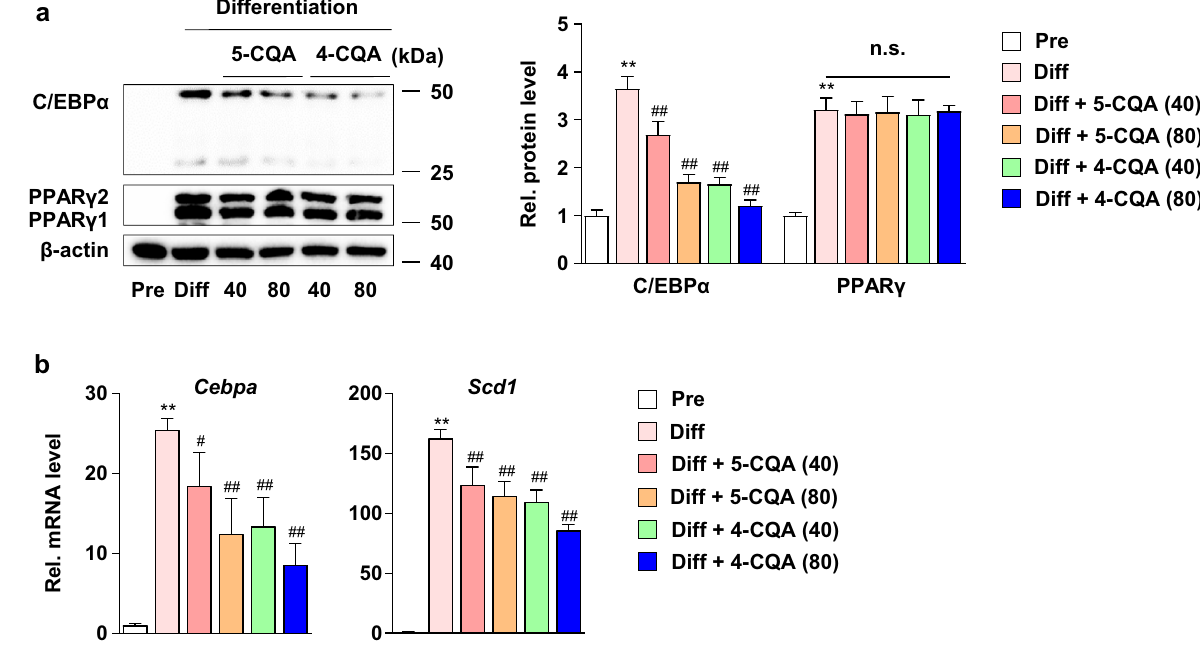
Figure 5. Effects of neochlorogenic acid (5-CQA) and cryptochlorogenic acid (4-CQA) on adipogenic factor expression in 3T3-L1 cells. ( a ) Effects of 5-CQA and 4-CQA on C/EBPα and PPARγ protein expression in 3T3- L1 preadipocytes and adipocytes. 3T3-L1 adipocytes were treated with 5-CQA (40 and 80 μM) and 4-CQA (40 or 80 μM) for 8 days. ( b ) Effects of 5-CQA and 4-CQA on Cebpa and Scd1 mRNA expression in 3T3-L1 cells. 3T3-L1 adipocytes were treated with 5-CQA (40 and 80 μM) and 4-CQA (40 and 80 μM) for 8 days. ** P < 0.01 vs. Pre, # P < 0.05 and ## P < 0.01 vs. Diff, n.s.; not significant. Data are presented as the mean ±